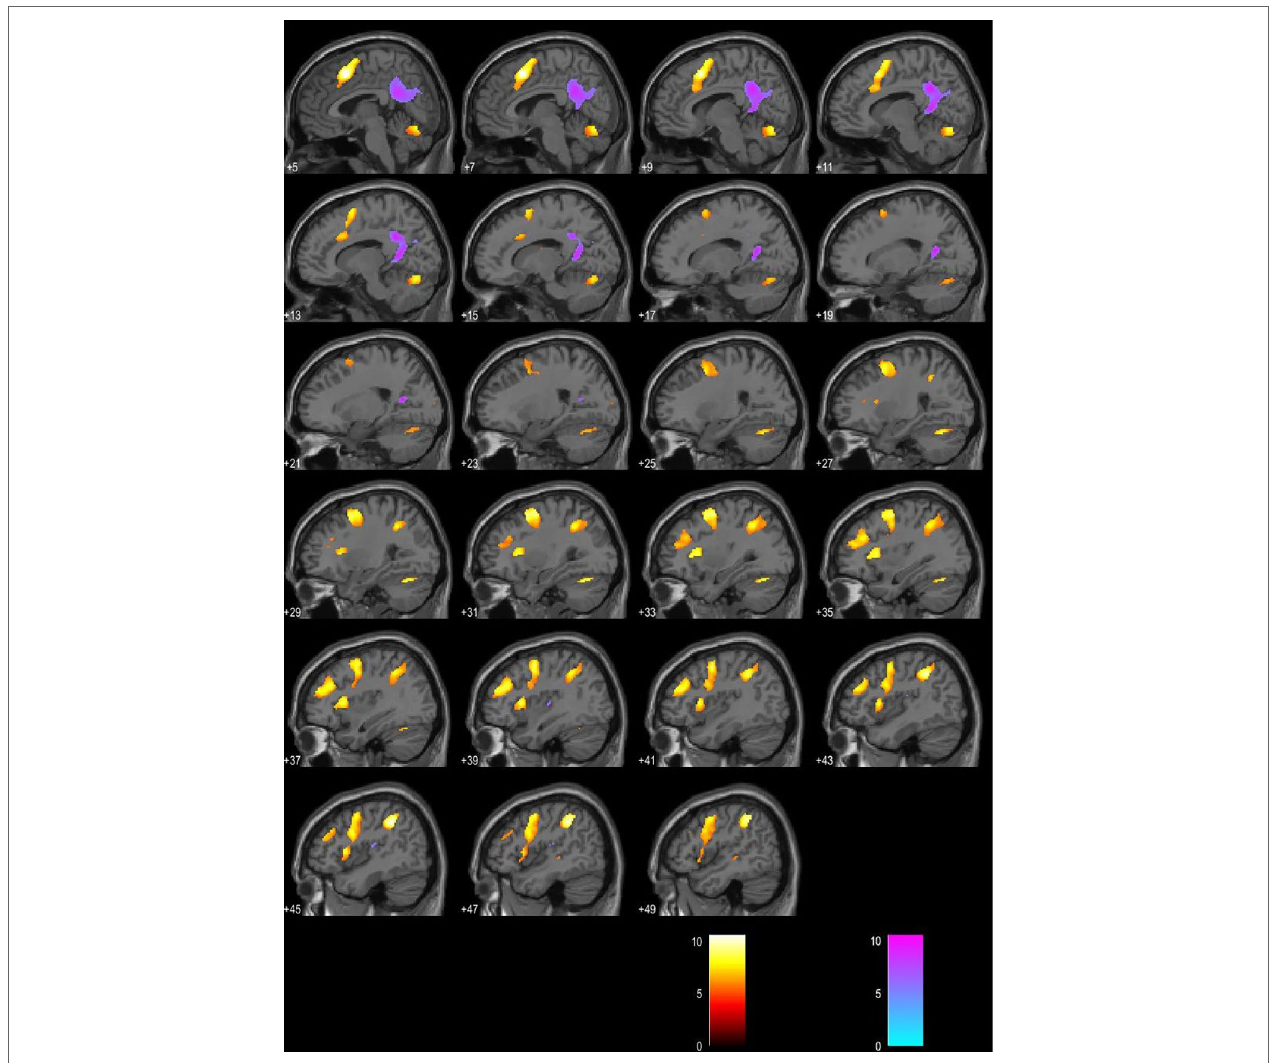
FIGURE 3 | Blood oxygen level–dependent (BOLD) signal associated with higher Modified Fatigue Impact Scale (MFIS) score is presented in the red color map. BOLD signal associated with lower MFIS score is presented in the blue color map. Presented in the sagittal